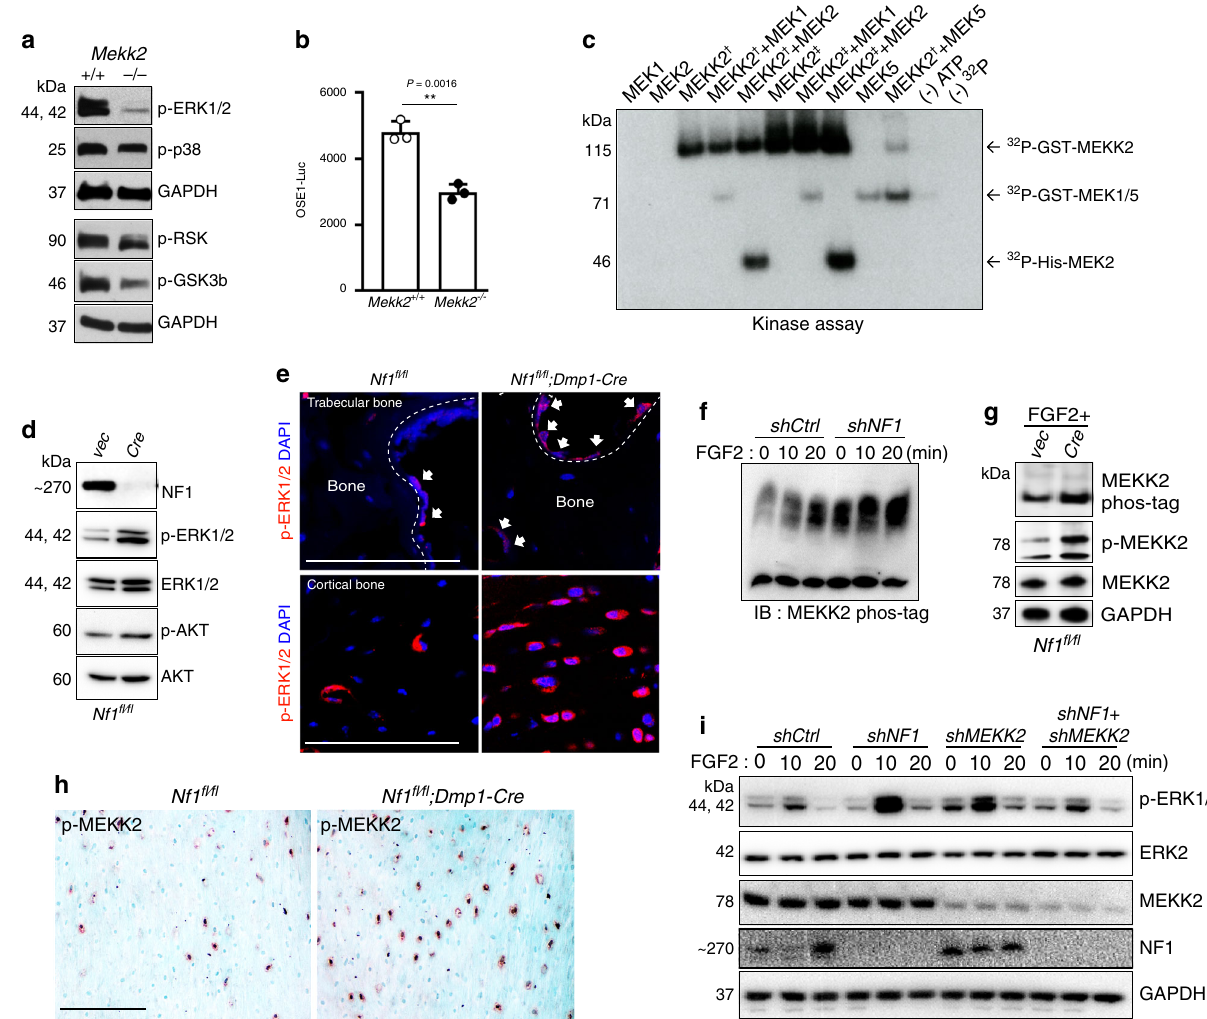
Fig. 1 The MAP3K MEKK2 contributes to the aberrant ERK activation occurring with NF1 loss. a ERK phosphorylation levels were assessed by immunoblotting in primary COBs isolated from Mekk2 + / + and Mekk2 − / − mice. Cell lysates were immunoblotted with the indicated antibodies. b Primary Mekk2 + / + and Mekk2 − / − COBs were transfected with the OSE1-Luc (ATF4) reporter ( n = 3 biologically independent samples). Mean ± s.e.m., unpaired, two-tailed Student ’ s t test: ** P < 0.01. c Puri fi ed unactivated GST-MEK1 or His-MEK2 was incubated with puri fi ed GST-MEKK2 and an in vitro kinase assay was conducted. Two types of recombinant GST-tagged MEKK2 as indicated with a dagger and double dagger were used as described in the Methods section. GST-MEK5 was used as a positive control. d Representative blot from three independent experiments. Primary Nf1 fl / fl COBs infected with either immunoblotting. e Representative images of immunostaining for p-ERK (red) in femurs from 16 weeks old Nf1 fl / fl and Nf1 fl / fl ;Dmp1-Cre mice. White arrows indicate p-ERK positive osteoblasts. Nuclei are counterstained with DAPI (blue) and scale bar indicates 100 µ m. Three independent fi elds were examined